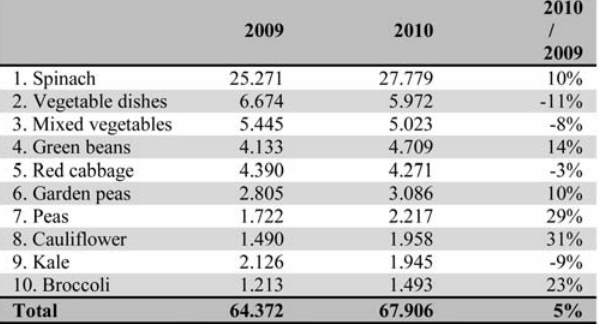
Source: PT / Nielsen